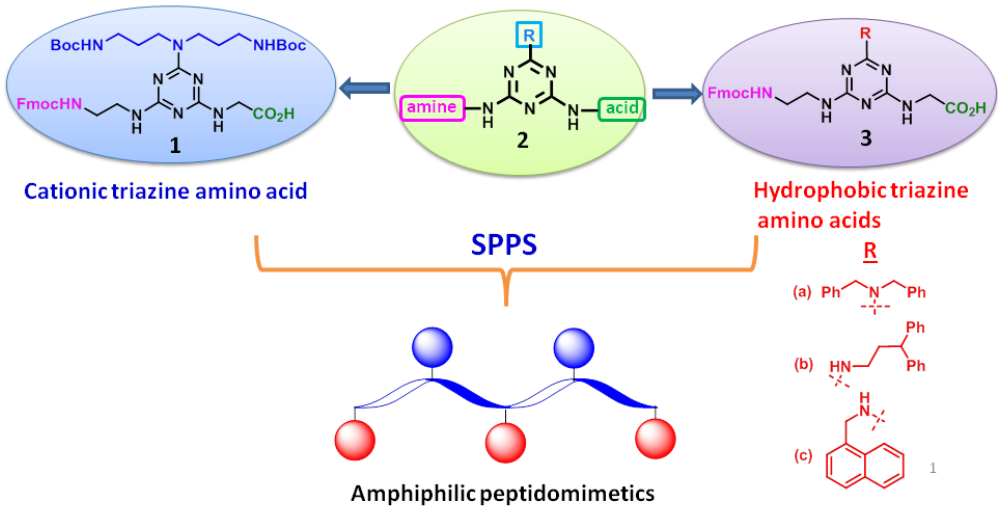
Figure 1. Designing strategy of Fmoc-triazine amino acids. SPPS = solid-phase peptide synthesis.